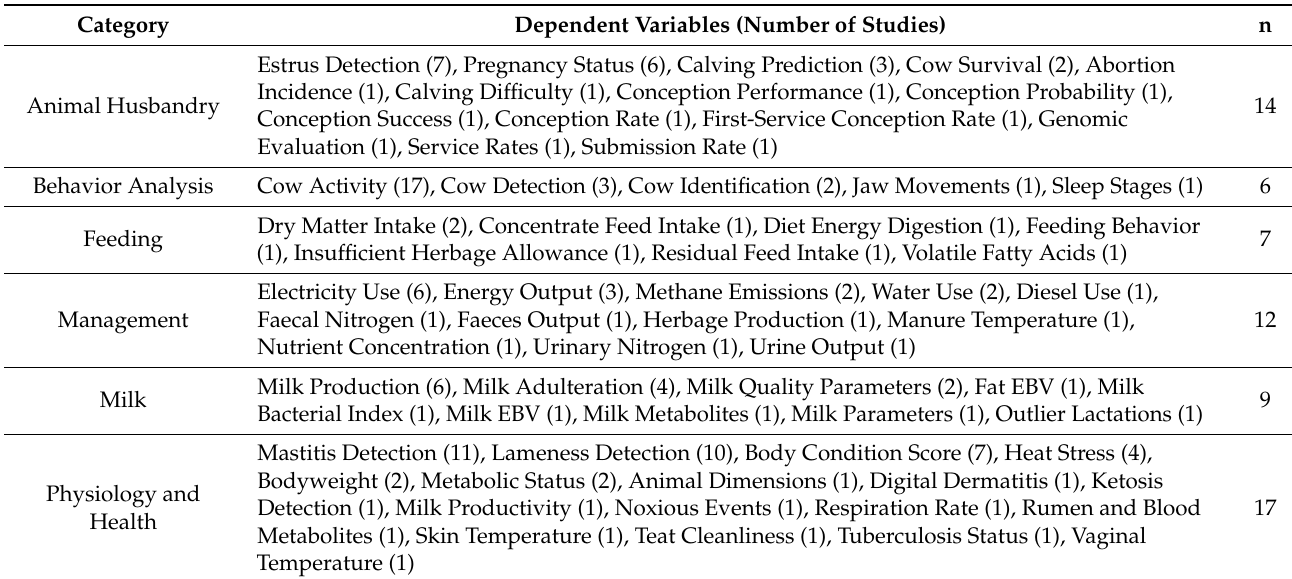
Table A1. Specific dependent variables used per research category.